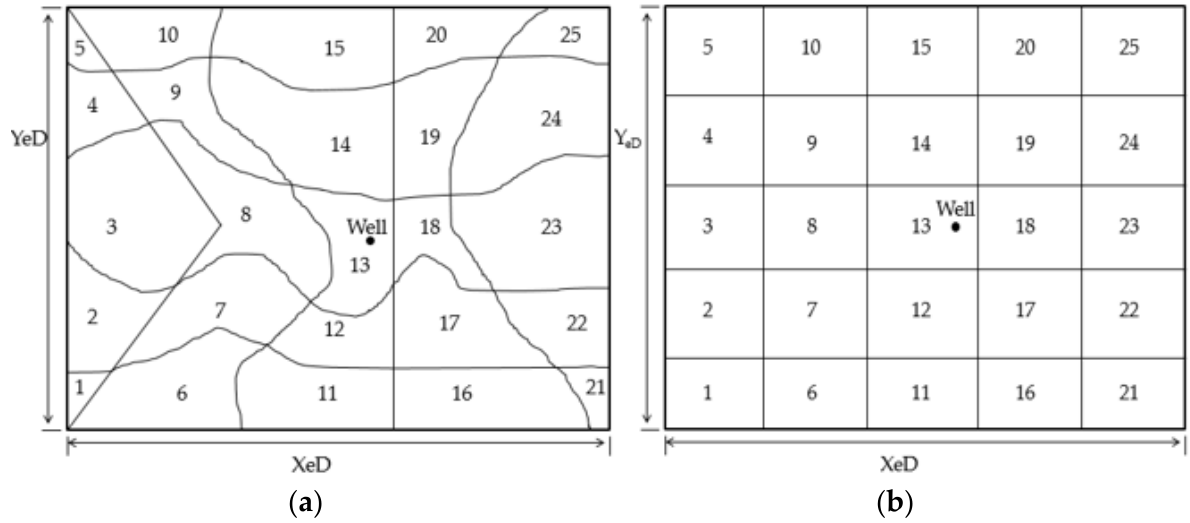
Figure 3. Schematic reservoir with ( a ) an irregular-gridding system and ( b ) a rectangular gridding system, 𝑋 𝑒𝐷 = 50 and 𝑌 𝑒𝐷 = 50 .